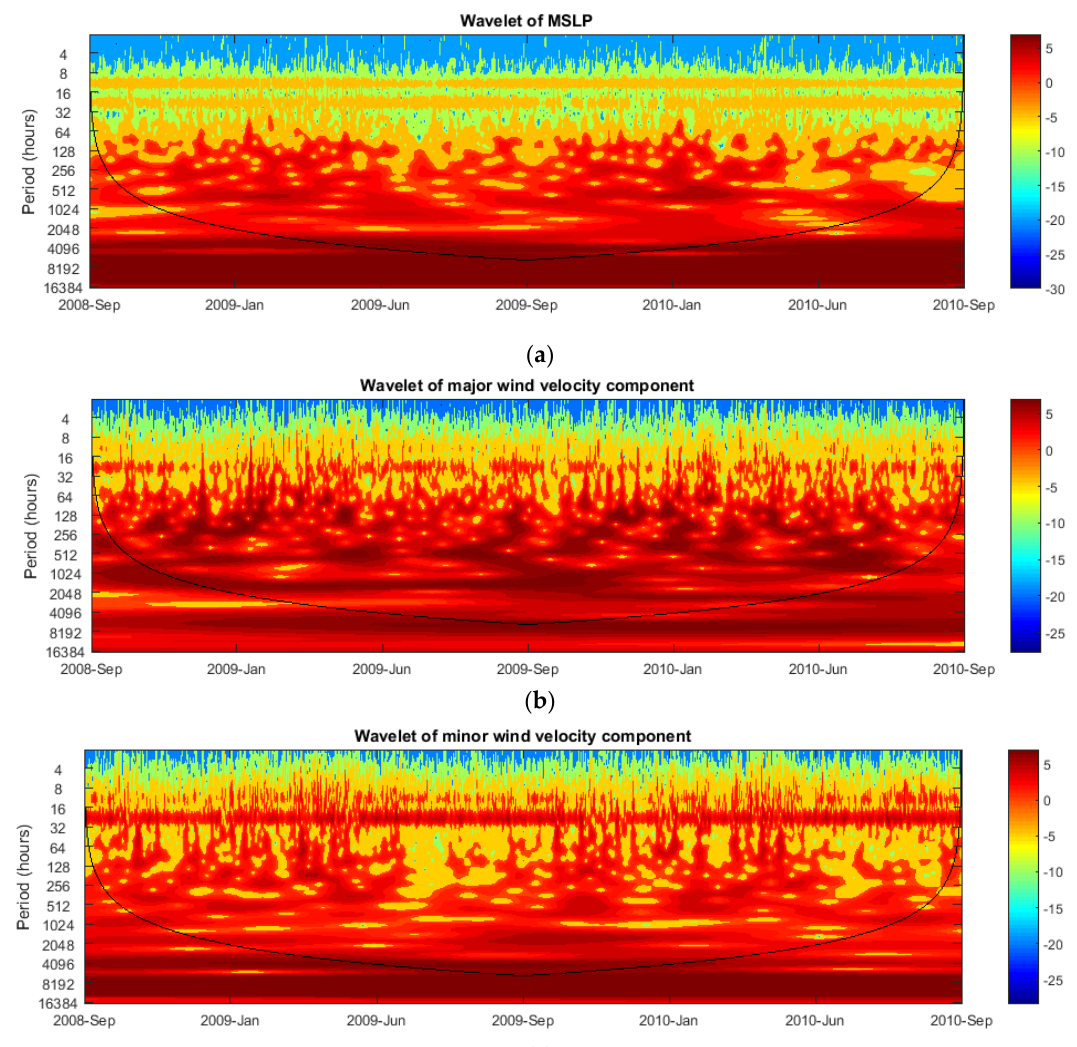
Figure 9. Typical results of wavelet analysis on ( a ) the meteorological parameters including MSLP, ( b ) Major wind velocity component, and ( c ) minor wind velocity component (bottom) for Bushehr station.